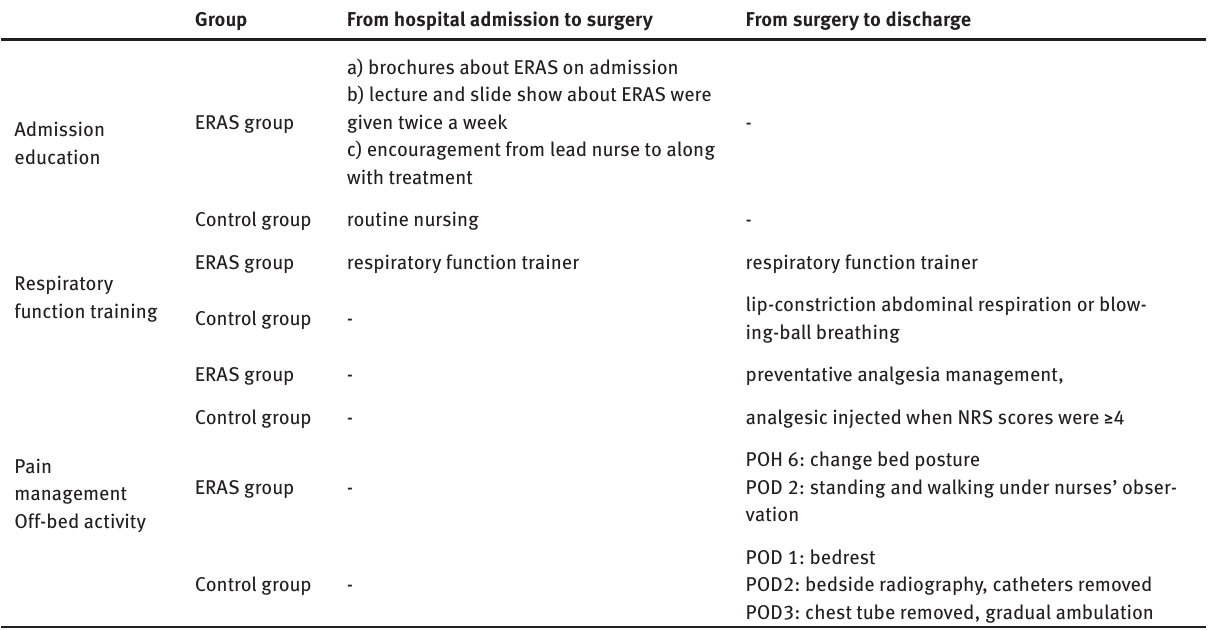
Table 1: Comparison of Perioperative Nursing Measures Group From hospital admission to surgery From surgery to discharge